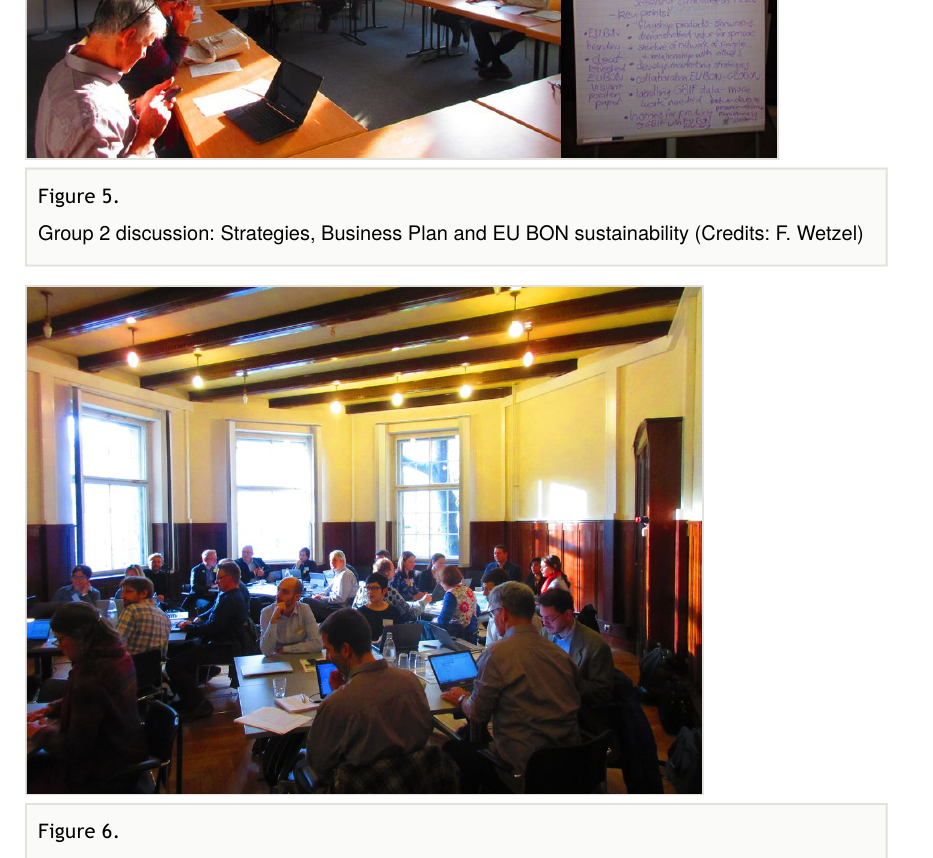
Participants of the 4th EU BON Stakeholder Roundtable (Credits: F.